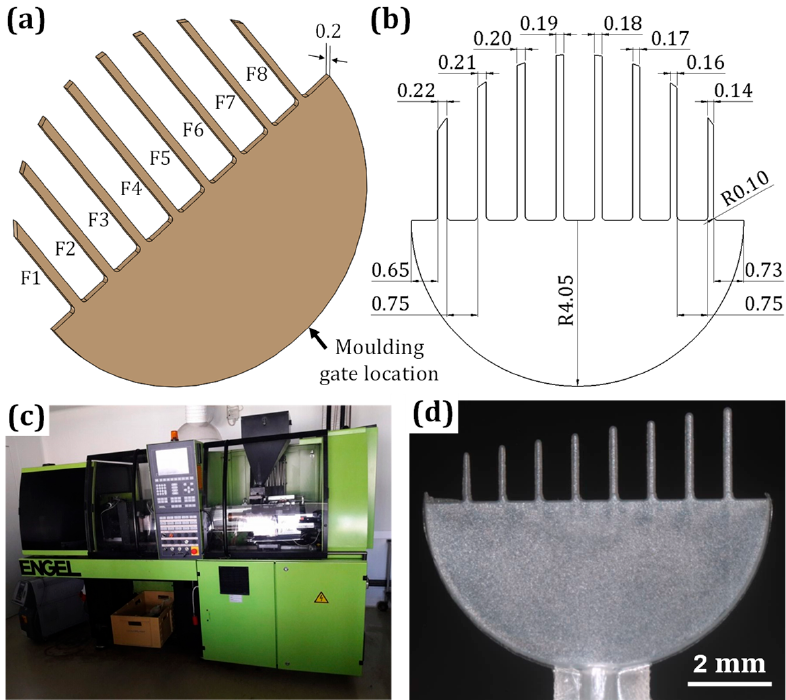
Figure 2. CAD model ( a ) and 2D drawing ( b ) of the chosen test part; molding machine used for the production of plastic parts ( c ); and a molded plastic part with ABS material ( d ).